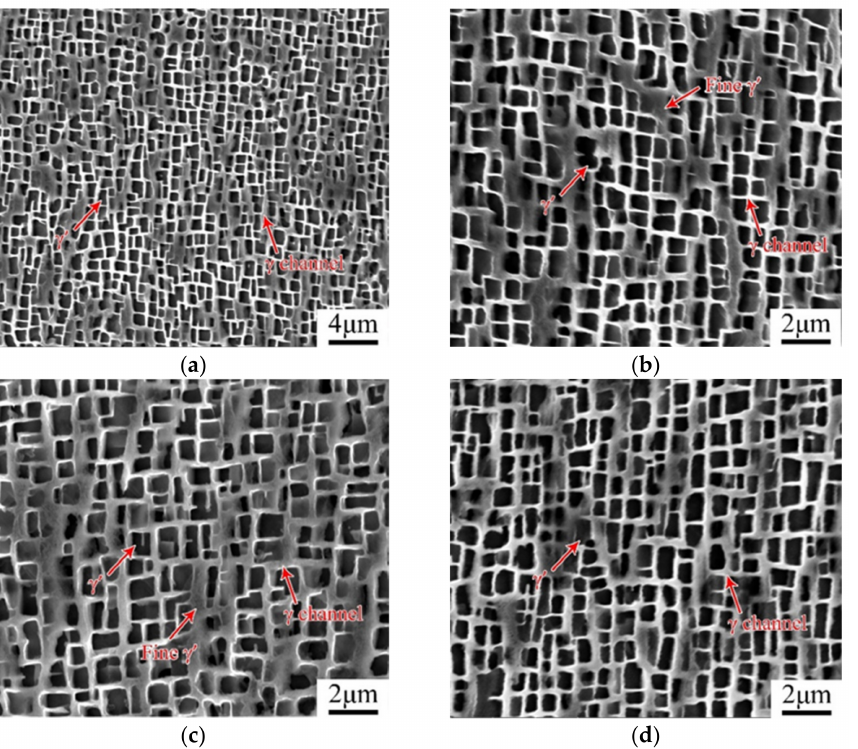
Figure 4. SEM-SE images of γ ’ precipitates in the dendrite core regions at the longitudinal sections close to the fracture surface of tensile rupture specimens of DZ406 superalloy: a lower magnification ( a ) and a higher magnification at − 125 ◦ C ( b ), 25 ◦ C ( c ) and 1000 ◦ C ( d ).